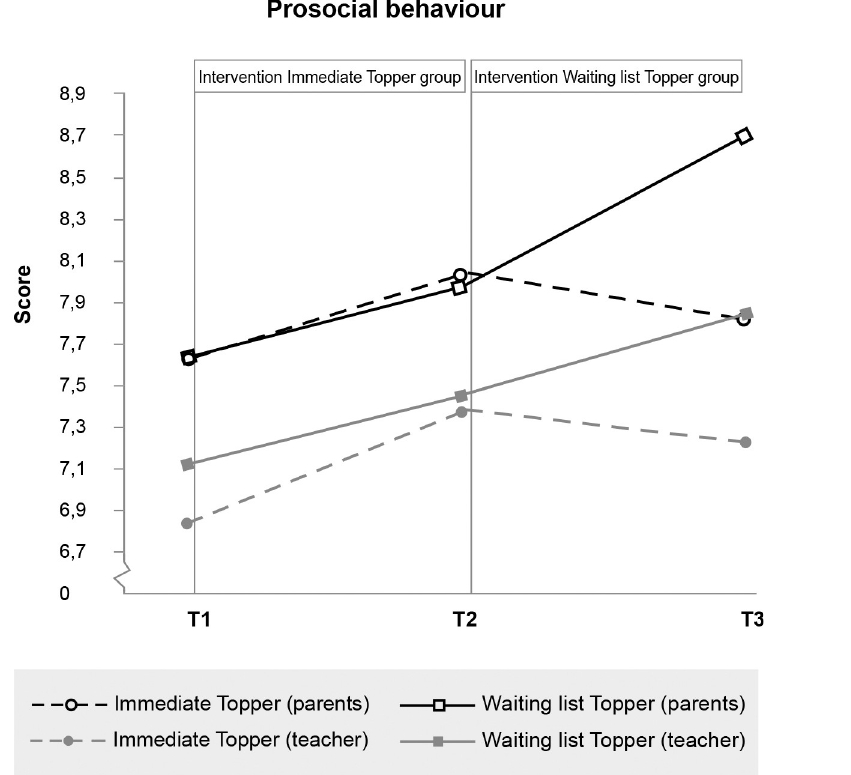
Fig 6. No significant effect of Topper Training on prosocial behaviour.